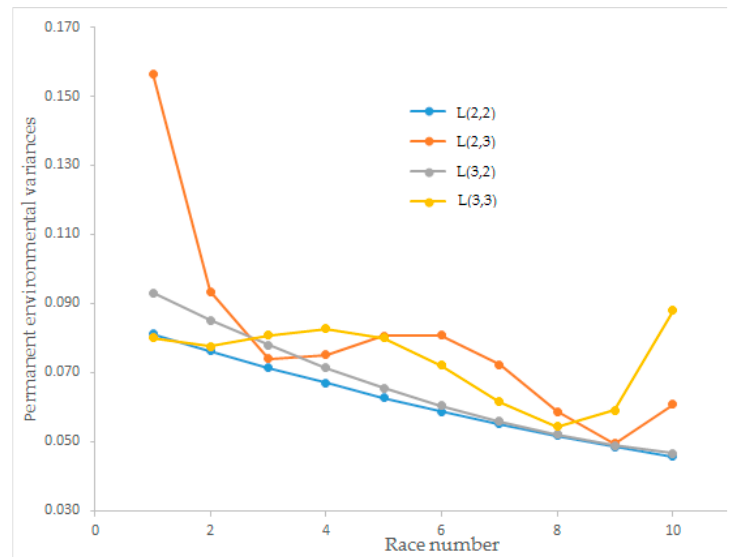
Figure 2. Estimation of permanent environmental variance for race speed from different orders of Legendre polynomial models.